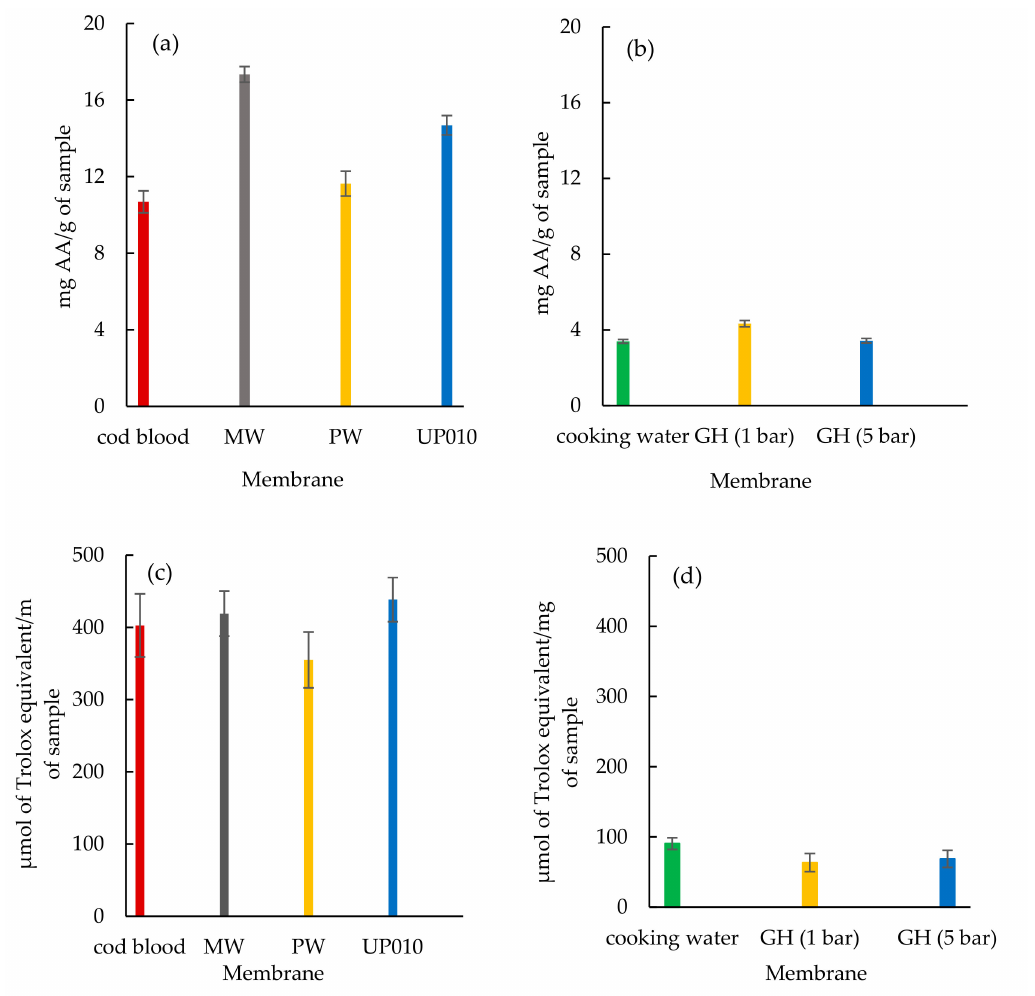
Figure 5. Antioxidant activities of fish by-products (codfish blood and sardine cooking wastewaters) and corresponding peptide fractions. ( a ) ABTS + radical scavenging activity for codfish blood and the corresponding peptide fractions from (MW, PW, and UP010 membranes), ( b ) ABTS + radical scavenging activity for cooking wastewaters and the corresponding peptide fractions from the GH membrane, using 1.0 bar and 5.0 bar of transmembrane pressure, ( c ) ORAC value for codfish blood and the corresponding peptide fractions from (MW, PW, and UP010 membranes) and ( d ) ORAC value for sardine cooking wastewaters and the corresponding peptide fraction from the GH membrane using 1.0 bar and 5.0 bar of transmembrane pressure. The results are shown as mean ± S.D. with three